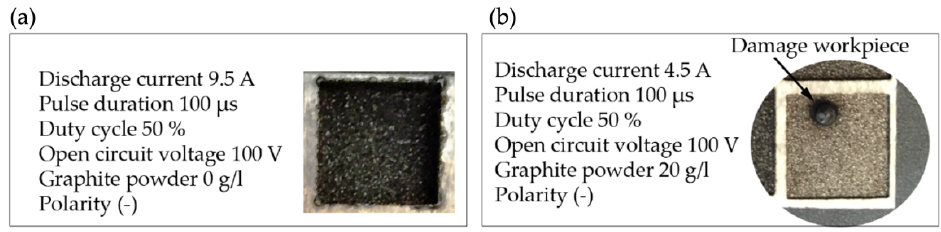
Figure 2. Preliminary experiments: ( a ) determination of the upper limit of the discharge current and ( b ) determination of the upper limit of the graphite powder concentration. Table 1. Machining conditions.